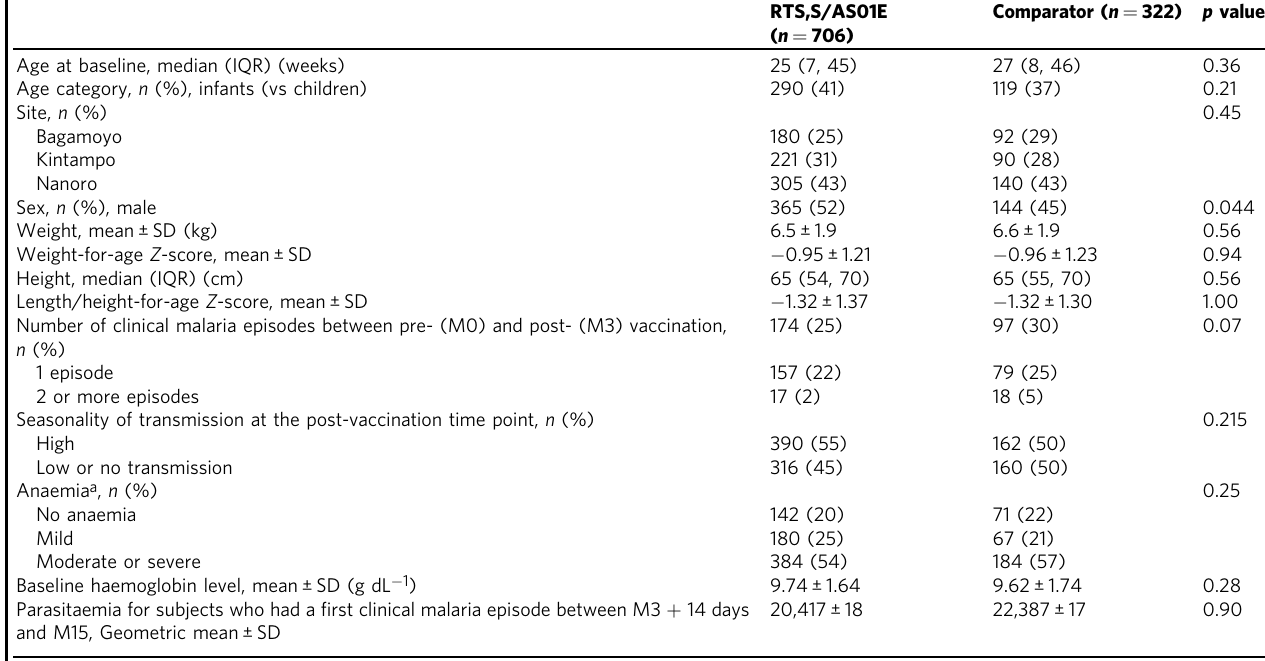
RTS,S/AS01E ( n = 706)